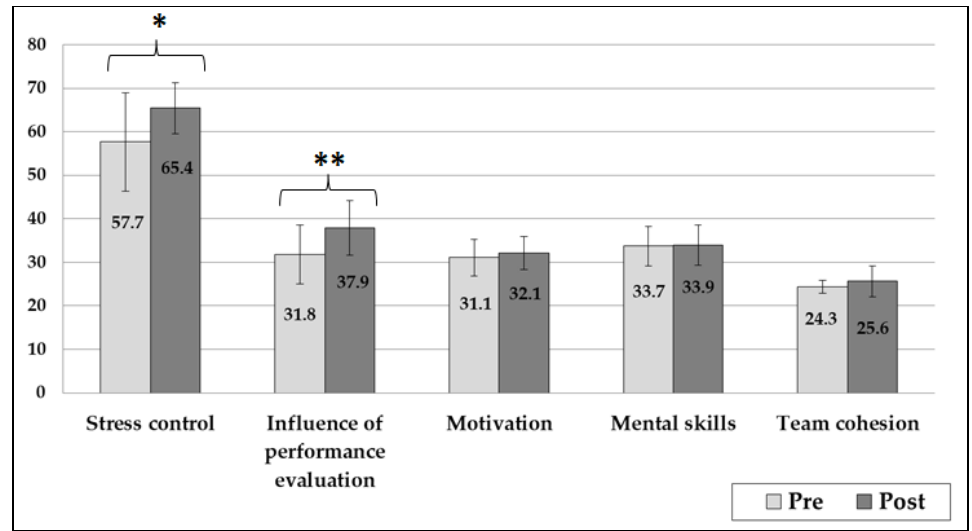
Figure 1. Changes in the psychological characteristics related to Sport Performance Questionnaire subscales (* p < 0.01; ** p < 0.001).